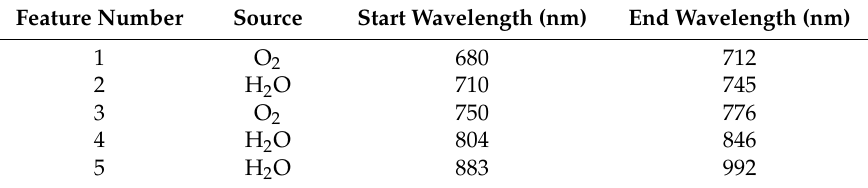
Table 4. Identified atmospheric absorption features in the spectral range covered by the CASI.